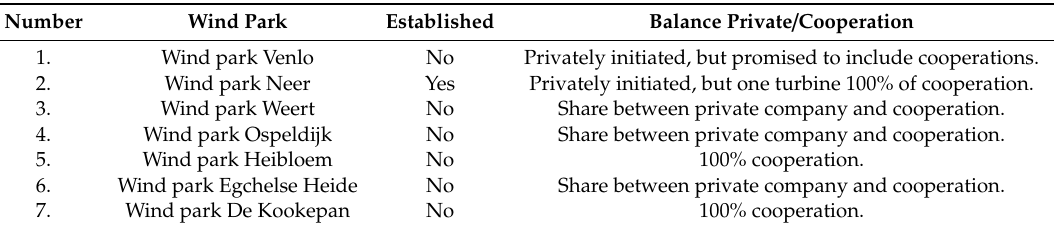
Table 3. Permitted wind parks in Limburg by August